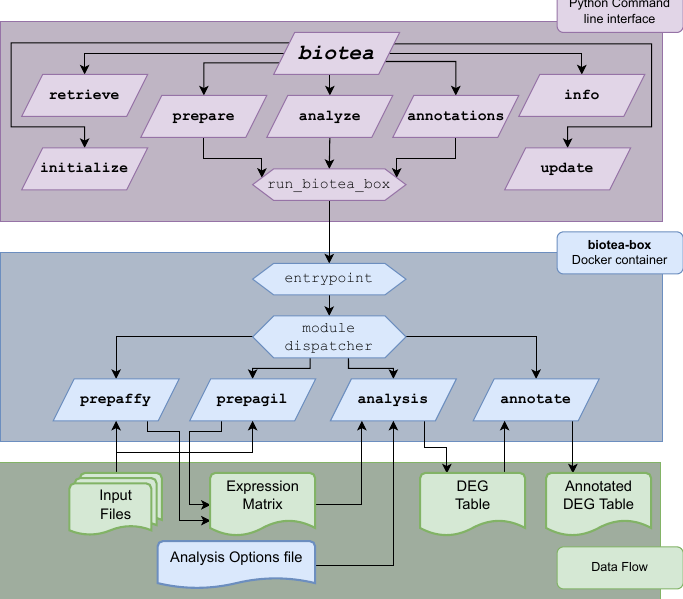
Figure 1. General structure of bioTEA. The python CLI is accessed with the biotea command. Launching of the Docker container is handled by a single function, run_biotea_box . A shared entrypoint is run upon starting the Docker container, which parses the options and runs the invoked module. File input and output are handled through Docker mounts to predetermined locations inside the running image. In the lower part of the figure, we provide a simplified schema of the input and outputs used by the various